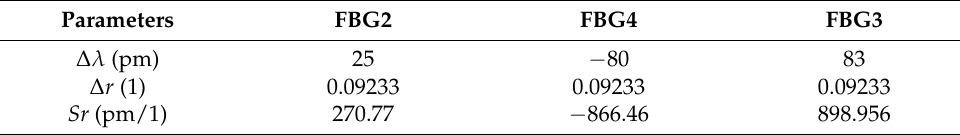
Table 10. Radian sensitivity of the two kinds of FBG sensors.